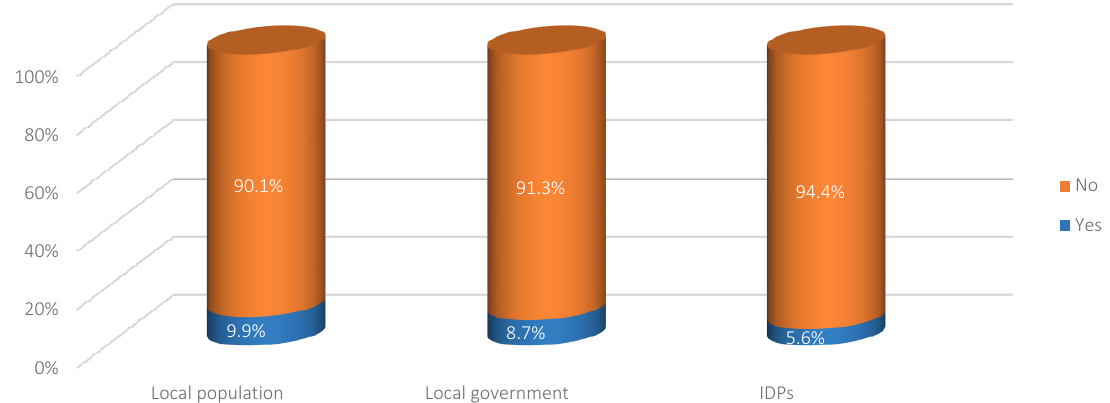
Figure 7. Conflicts of IDPs with the local population, local government, and other IDPs in the Pidberiztsivska community, % of